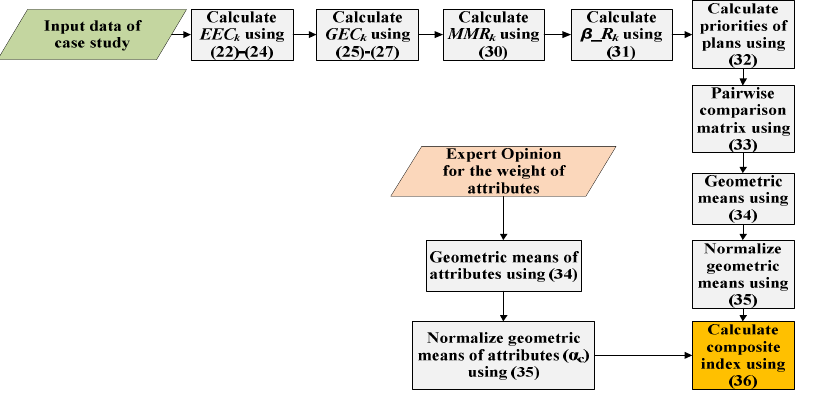
Figure 2. Flowchart of the proposed multi-attribute decision-making (MADM) method.